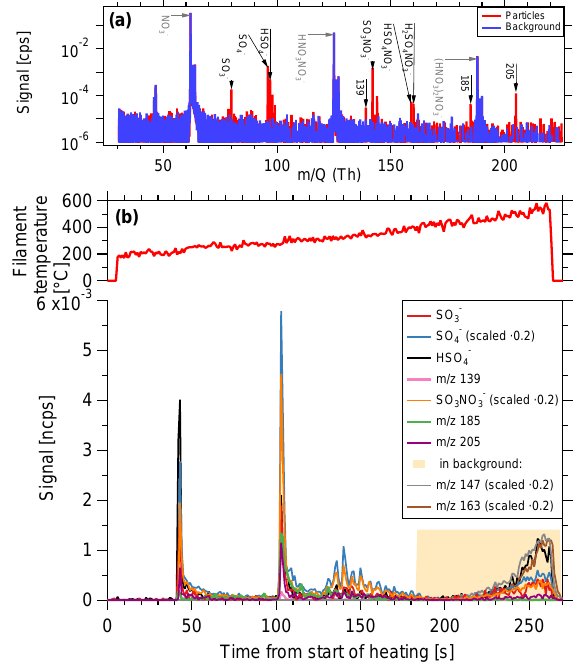
Figure 8. Composition measurement of 15nm particles generated from dimethylamine, sulfur dioxide and ozone in presence of UV light. (a) Spectrum of particle phase compared to the background. Prominent particle-phase peaks in black, primary ions in grey. (b) Time series of evaporation. As filament temperature increases, substances desorb from the filament and are depleted rapidly. At high temperatures, signals originating from the inlet line